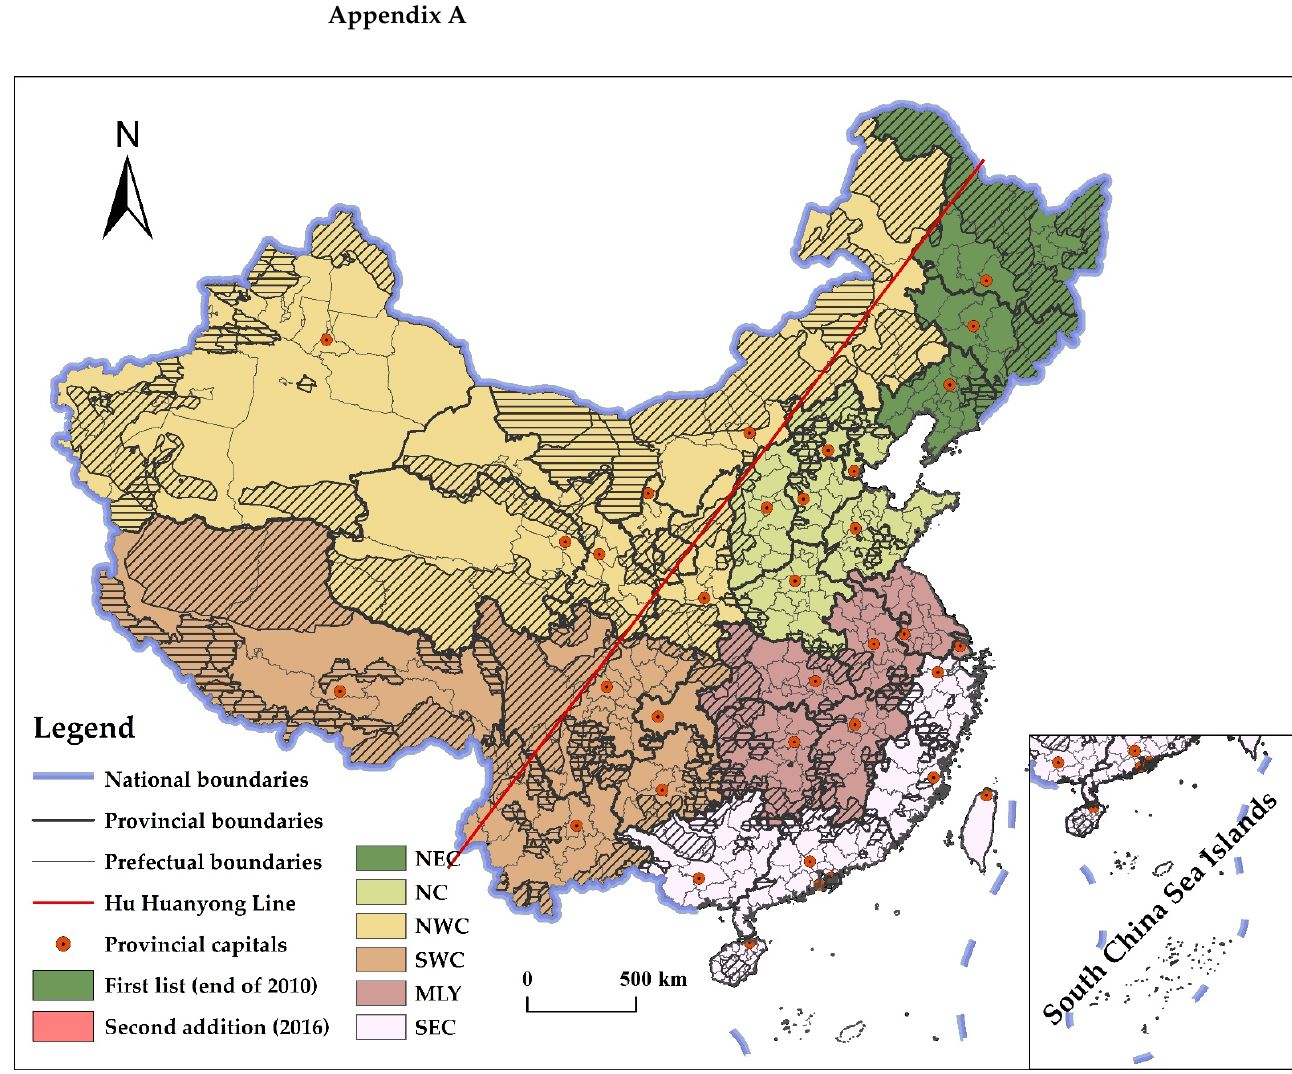
Figure A1. Distribution of NKEFAs and six geographic regions.